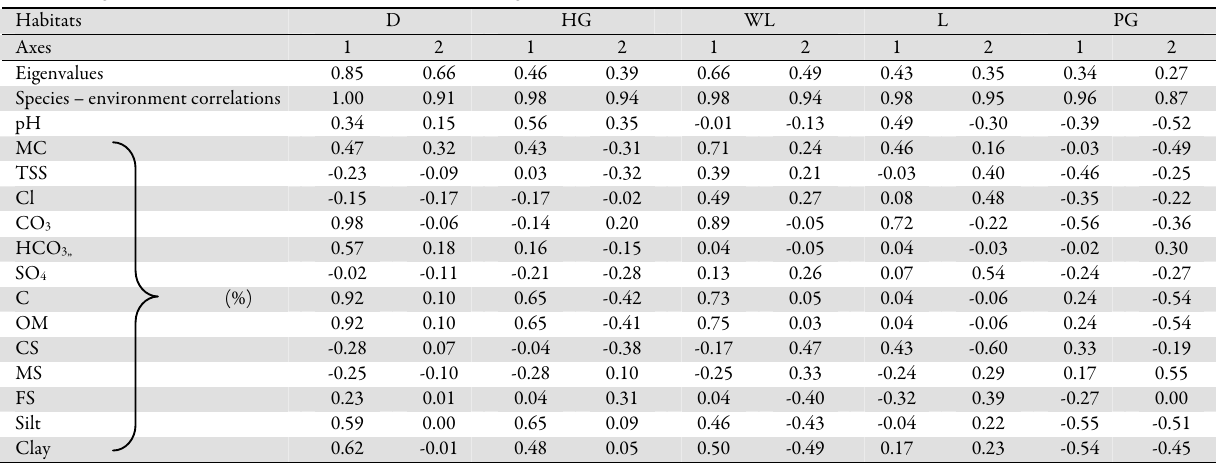
Table 4. Inter–set correlation of CCA analysis for the soil variables, together with eigenvalues and species–environment correlation in the 5 habitats;